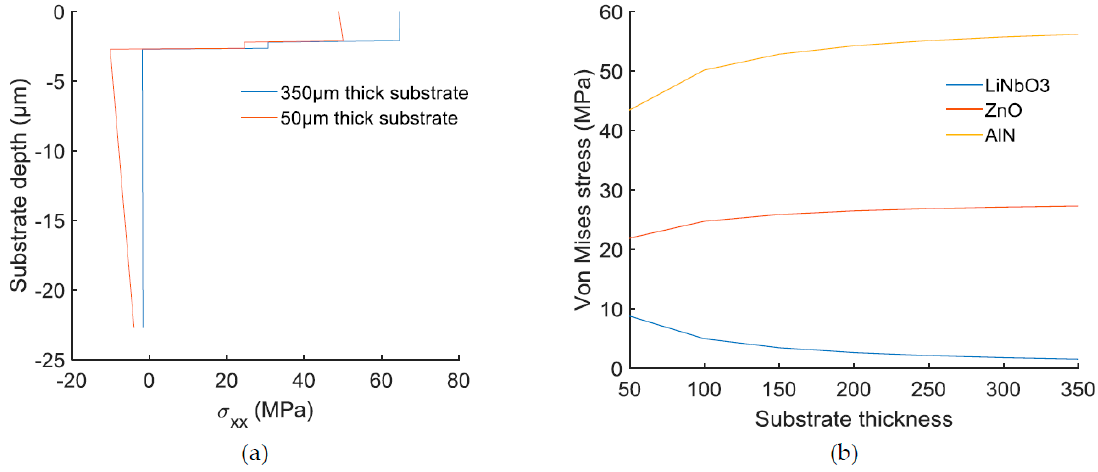
Figure 1. ( a ) Thermo-mechanical stress field σ xx generated in the AlN/ZnO/LNY + 128° (S1) structure, by a temperature increase of 20 °C. Two thicknesses of LN are considered here: 50 µm and 350 µm. ( b ) Evolution of the Von Mises stress in the layers, versus substrate (LN)